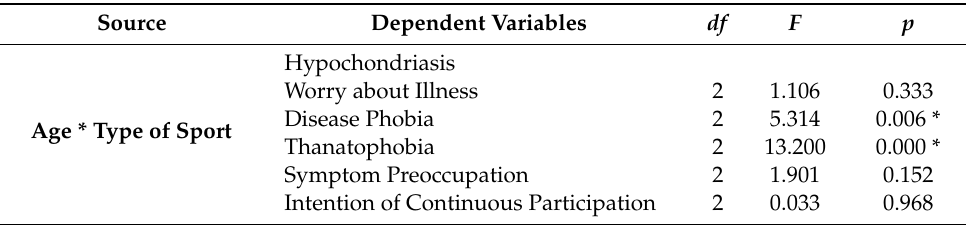
Table 6. Results of interaction effects of independent variables on dependent variables.